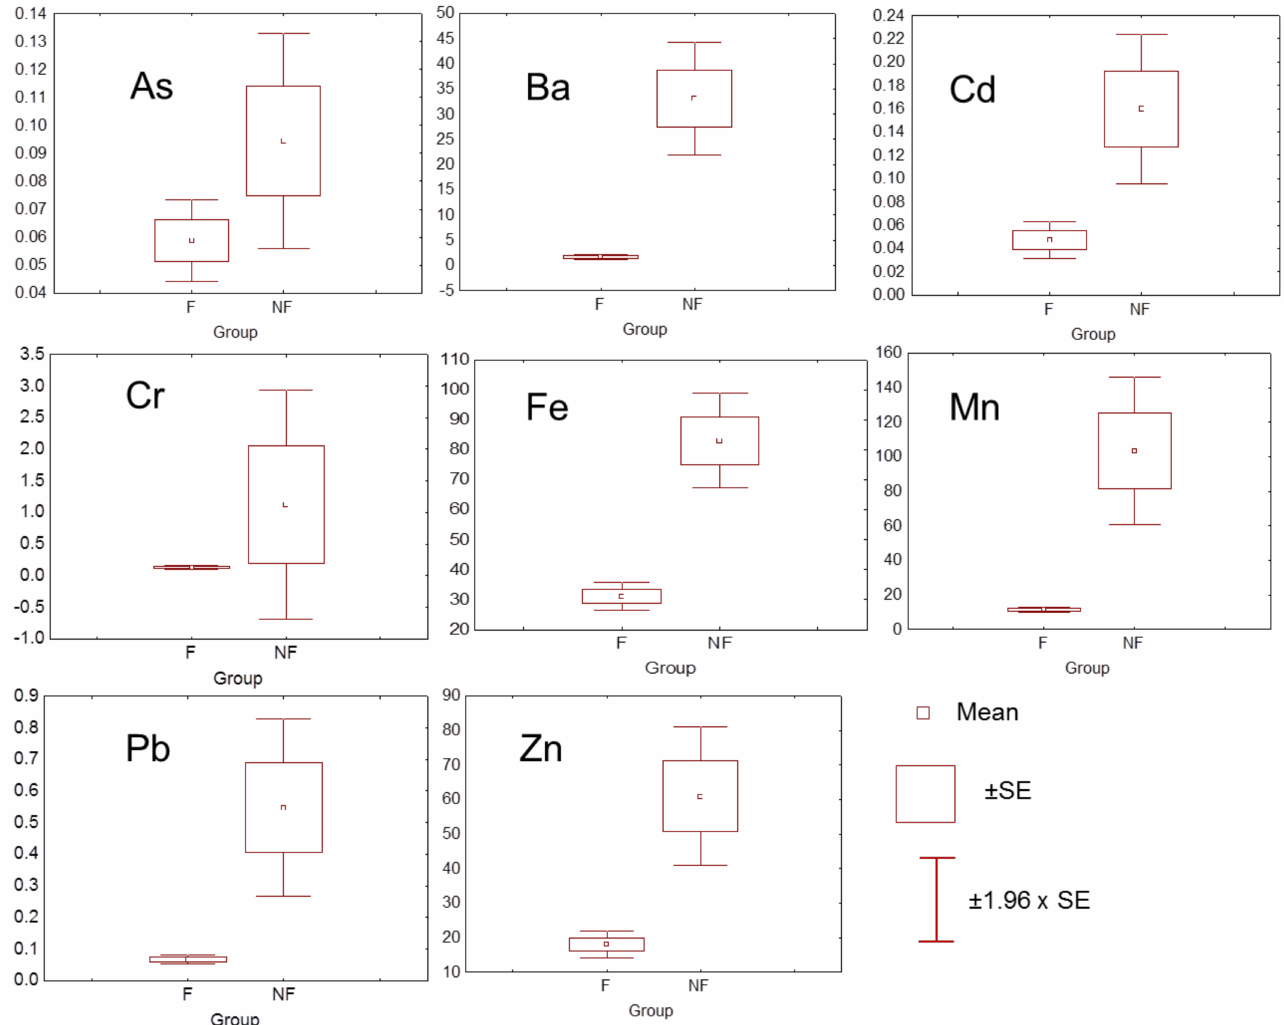
Figure 5. Potential toxic element concentration (in mg kg − 1 ) in urban garden grown species by fruit (F) and non-fruit (NF)